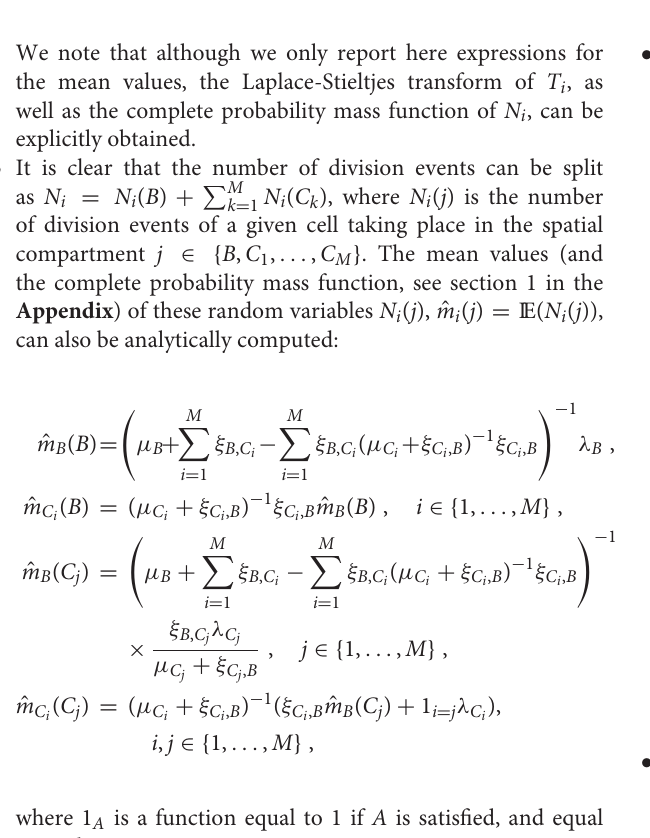
FIGURE 2 | One realization of the stochastic process shown in Figure 1 , and interpretation of the summary statistics. The dynamics mimics that of Hawkins et al. ( 35, Supplementary Material , Figure 2A) and Piltti et al. (36, Figure 2). In this example, M = 2, and a striped color identifies the original cell being tracked. A given color indicates the spatial location of each cell (red: blood, blue: C 1 , green: C 2 ). In this realization, G B = 11, N B = N B ( B ) + N B ( C 1 ) + N B ( C 2 ) = 1 + 0 + 1 = 2. The compartment before death is C 2